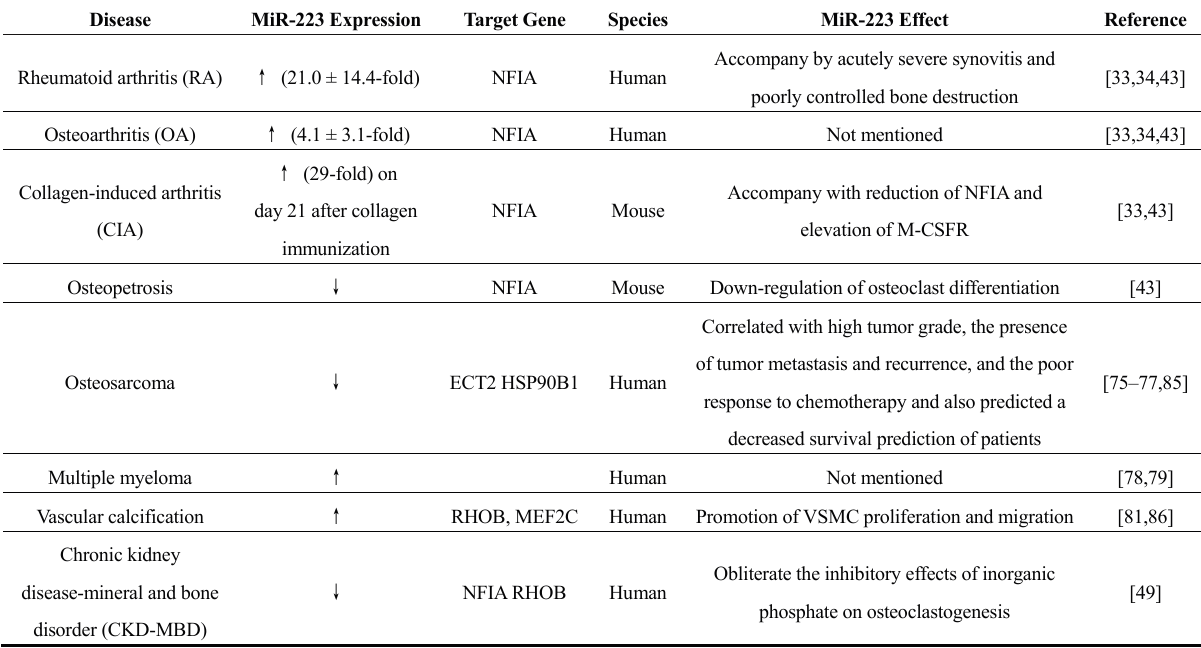
Table 1. MiR-223 in diseases with bone